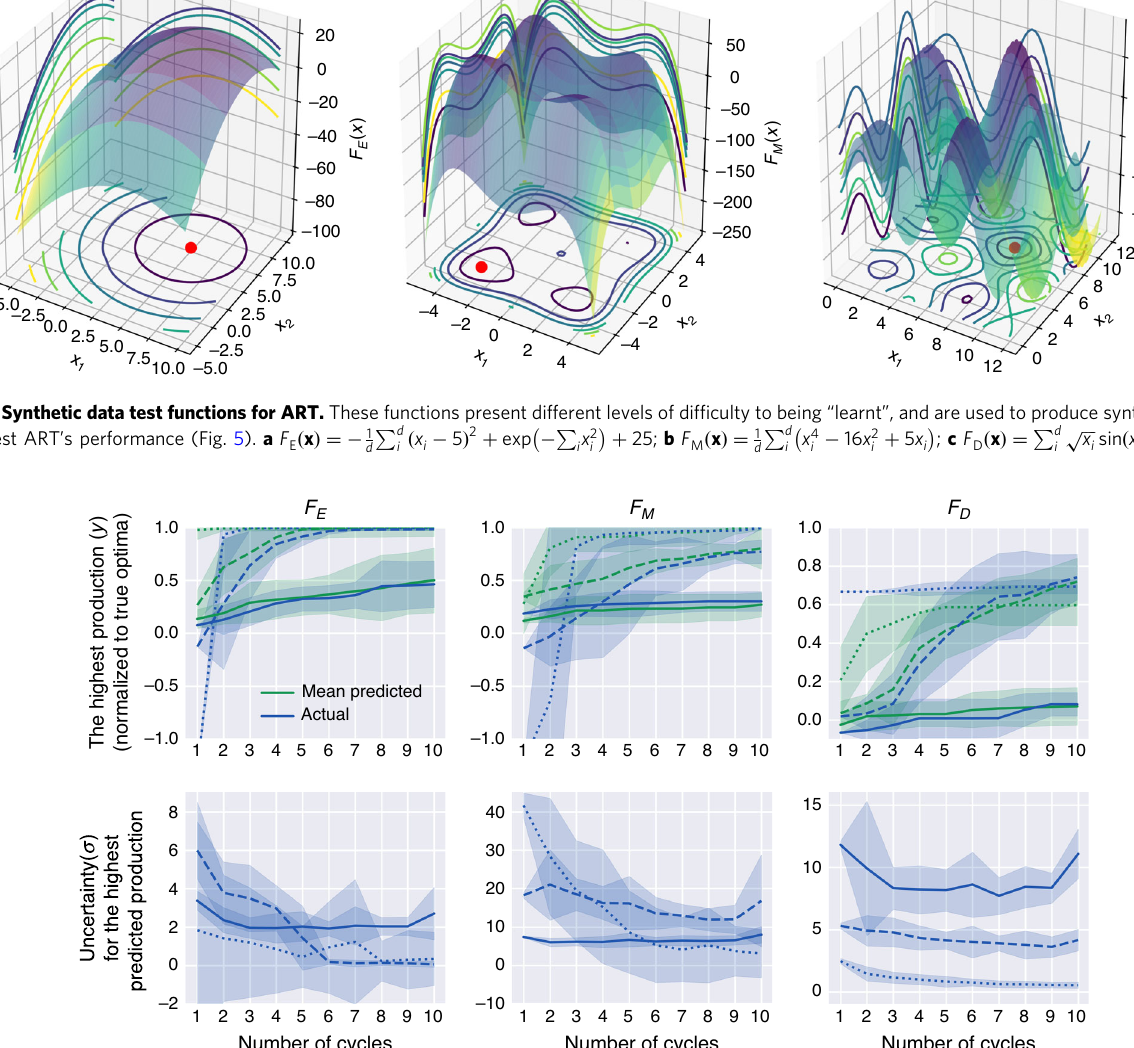
Fig. 5 ART performance improves signi fi cantly beyond the usual two DBTL cycles. Here we show the results of testing ART ’ s performance with synthetic data obtained from functions of different levels of complexity (Fig. 4), different phase space dimensions (2, 10, and 50), and different amounts of training data (DBTL cycles). The top row presents the results of the simulated metabolic engineering in terms of highest production achieved so far for each cycle (as well as the corresponding ART predictions). The production increases monotonically with a rate that decreases as the problem is harder to learn, and the dimensionality increases. The bottom row shows the uncertainty in ART ’ s production prediction, given by the standard deviation of the response distribution (Eq. (2)). This uncertainty decreases markedly with the number of DBTL cycles, except for the highest number of dimensions. In each plot, lines and shaded areas represent the estimated mean values and 95% con fi dence intervals, respectively, over ten repeated runs. Mean Absolute Error (MAE) and training and test set de fi nitions can be found in Supplementary Fig.